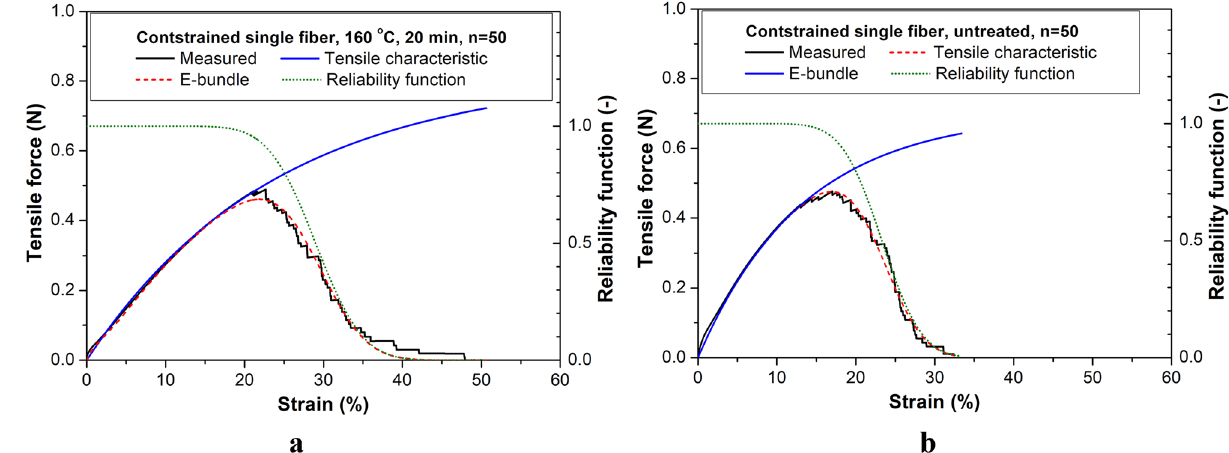
Figure 10. Measured mean tensile test curve, and the fitted tensile characteristic, reliability function, and nonlinear E-bundle curve of constrained fibers ( a ) and rovings ( b ), with heat treatment (160 °C, 20